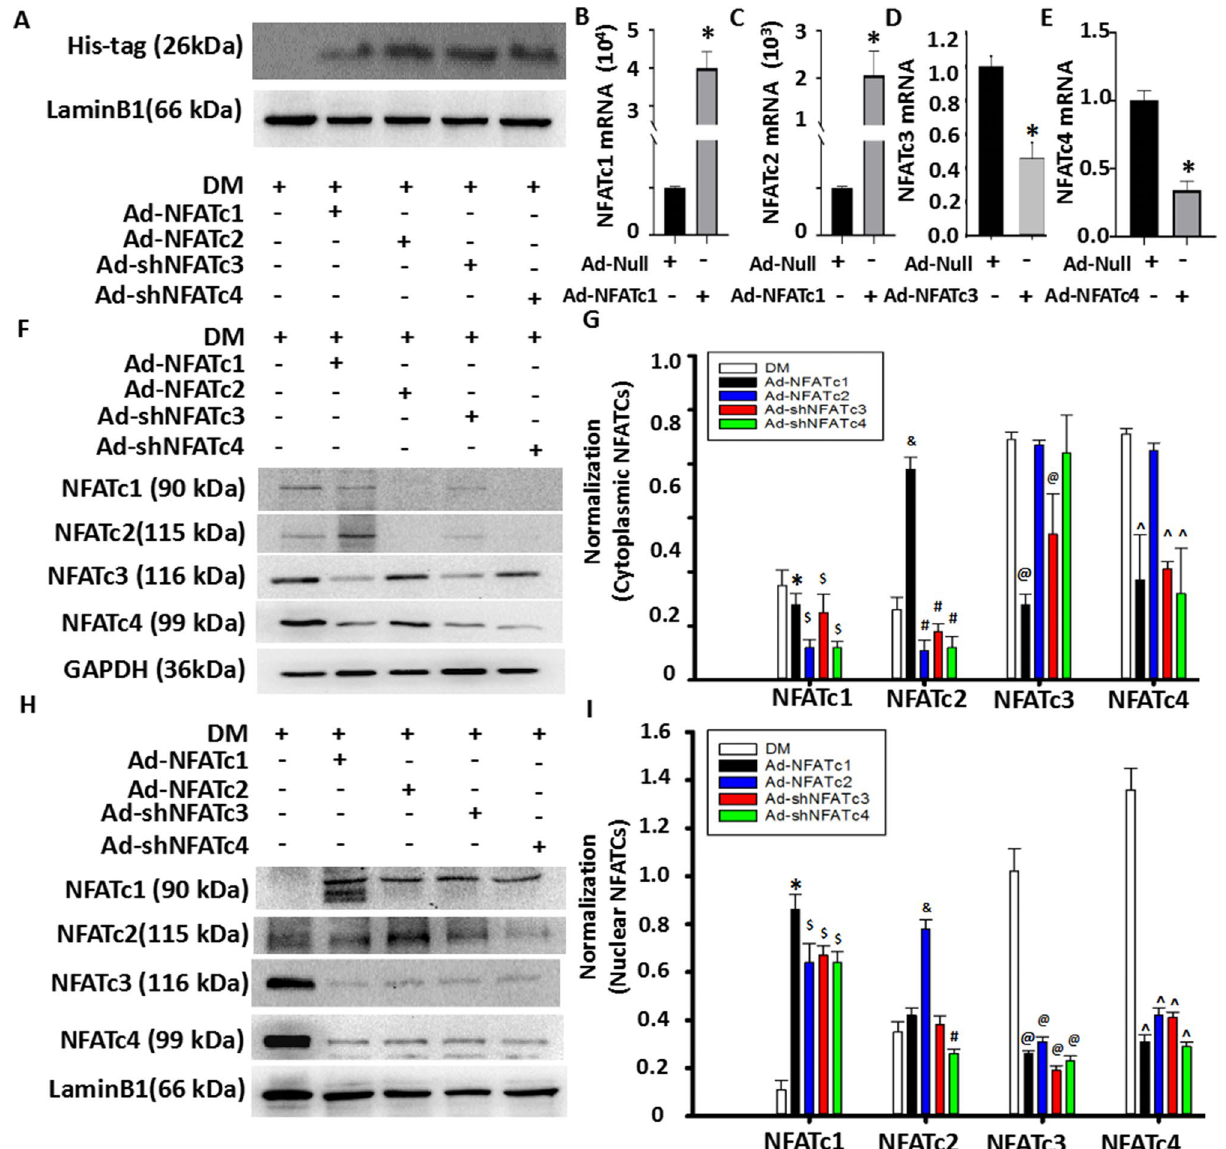
Figure 5. Transfection efficiency of NFAT overexpression or knockdown in C2C12 myoblast cells. ( A ) Western blot showed that the adenovirus vector was successfully transferred into myoblasts by detecting Flag-His after transfection with 100 optimal multiplications of infection (MOI) for the indicated adenovirus expression vectors. ( B – E ) Quantitative analysis of the transfection efficiency of these specific adenoviruses into C2C12 myoblast cells was determined by qPCR after myoblast cells were transfected with adenovirus-mediated overexpression of NFATc1 and NFATc2 or knockdown of NFATc3 and NFATc4 by shRNA (100 MOI) for 72 h. n = 3, *P < 0.05 versus Ad-Null. ( F ) Cytoplasmic proteins were evaluated by using western blotting. ( G ) Semi- quantitative assay from Fig. 5C. Three independently repeated experiments were performed. n = 3, * P < 0.05 versus DM; & P < 0.05 versus 10 −5 M ISO group; # P < 0.05 versus 10 −5 M ISO group; $ P < 0.05 versus 10 −5 M ISO + Ad-shNFATc3 group. ( H – I ) Western blot and semi-quantitative assays were used to evaluate nuclear proteins in these adenovirus-treated cells. n = 3, * P < 0.05 versus DM; & P < 0.05 versus 10 −5 M ISO group; # P < 0.05 versus 10 −5 M ISO group; $ P < 0.05 versus 10 −5 M ISO + Ad-shNFATc3 group; ^ P < 0.05 versus